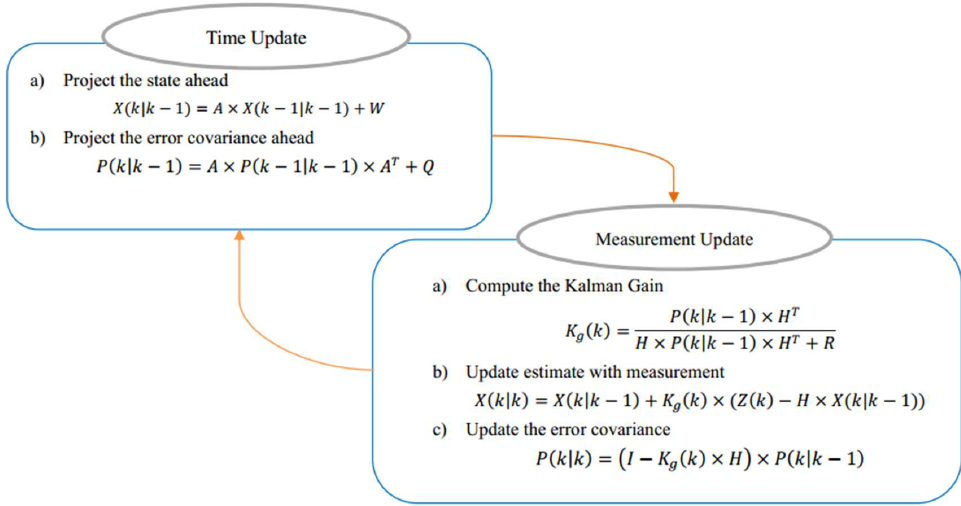
Figure 5. The process of predicting and updating Kalman filter.